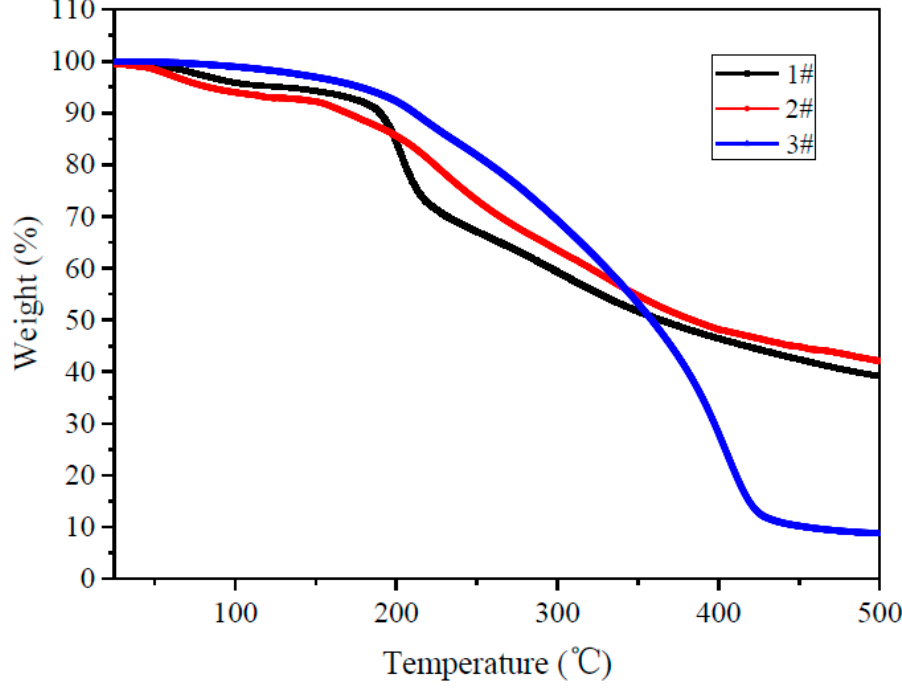
Figure 4. Thermogravimetric analysis of the microspheres (1 # TP, 2 # LK-CG, 3 # LK-CG-TP). The calorimetric thermograms of LK-CG-TP microspheres are depicted as a plot of heat flow (W/g) versus temperature ( ◦ C), and are shown in Figure 5. The DSC thermograms of LK-CG-TP microspheres showed quite broad melting transition temperature range. The melting temperature of LK-CG-TP was found to be around 69 ◦ C (Figure 5). The glass transition (Tg) of the microspheres was centered at 89.21 ◦ C, which indicated the thermal stability of the microspheres under lower temperature. With the temperature raised (>Tg) in the subsequent heating scan, a sharp endothermic peak was formed due to possible LK-CG-TP degradation (Figure 5).